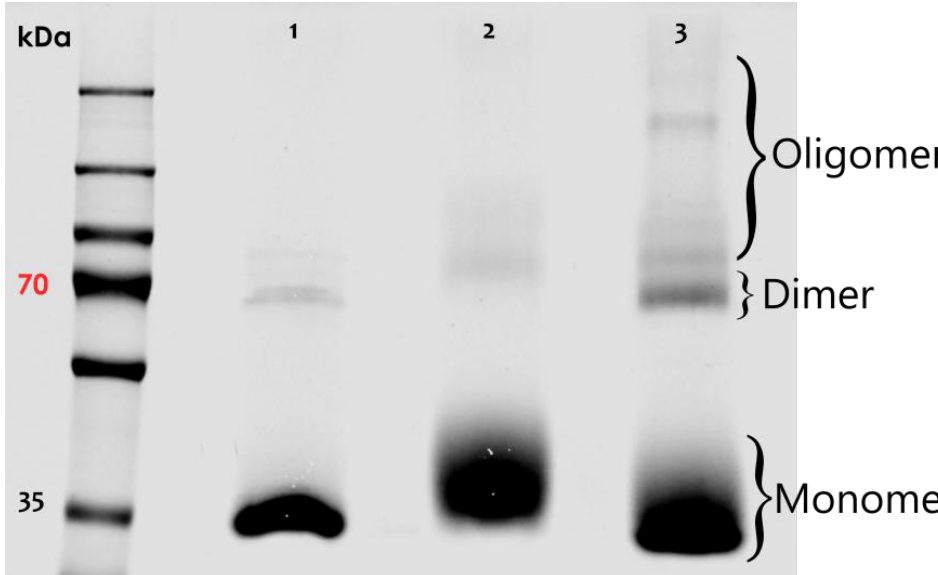
Figure 2. SDS-PAGE of crosslinking reactions involving alkylated AnxA2 wild-type (WT). Lane 1: Control#1(AnxA2WT + Ca 2 + ); lane2: Control#2(AnxA2WT + LUVs + EGTA + Biotin3xNHSX-Linker); lane 3: Ca 2 + / membrane sample (AnxA2 WT + LUVs + Ca 2 + + Biotin3xNHSX-Linker). Brackets on the right indicate the positions of AnxA2 monomers, dimers, and oligomers. Dimer formation most likely occurs during sample preparation, whereas the oligomers likely present AnxA2 assemblies that form following membrane interaction and are then stabilized by the crosslinker. A representative result of n = 5 independently performed experiments is